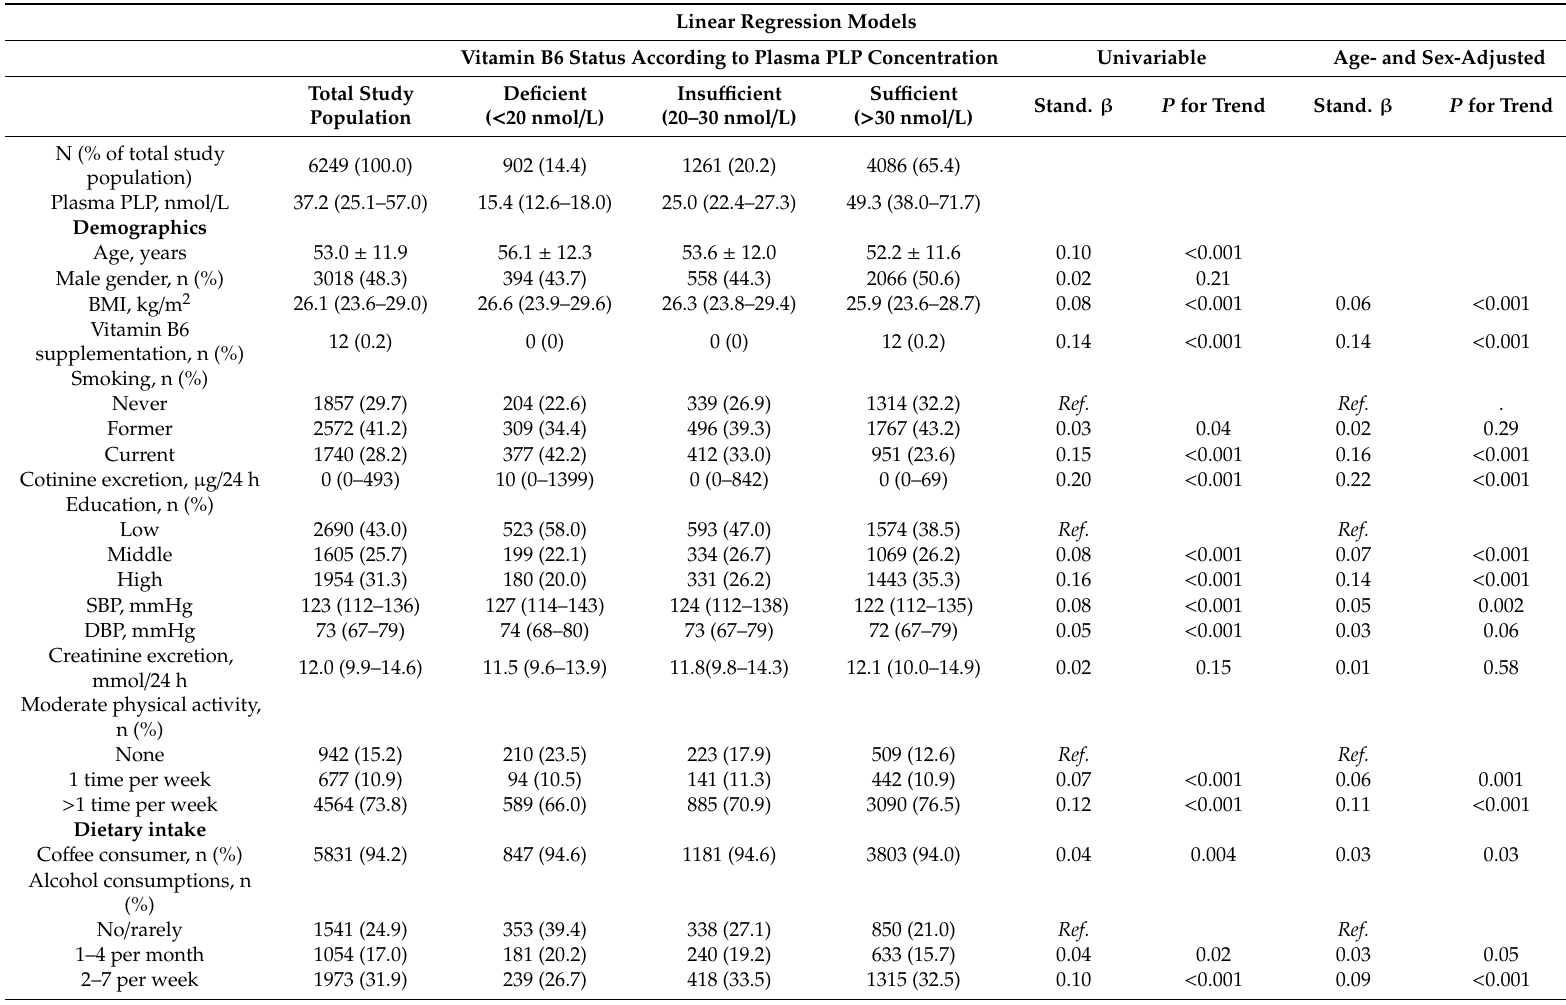
Table 1. Characteristics overall and according to vitamin B6 status and their association with plasma pyridoxal 5’-phosphate among 6 249 PREVEND study participants. Linear Regression Models